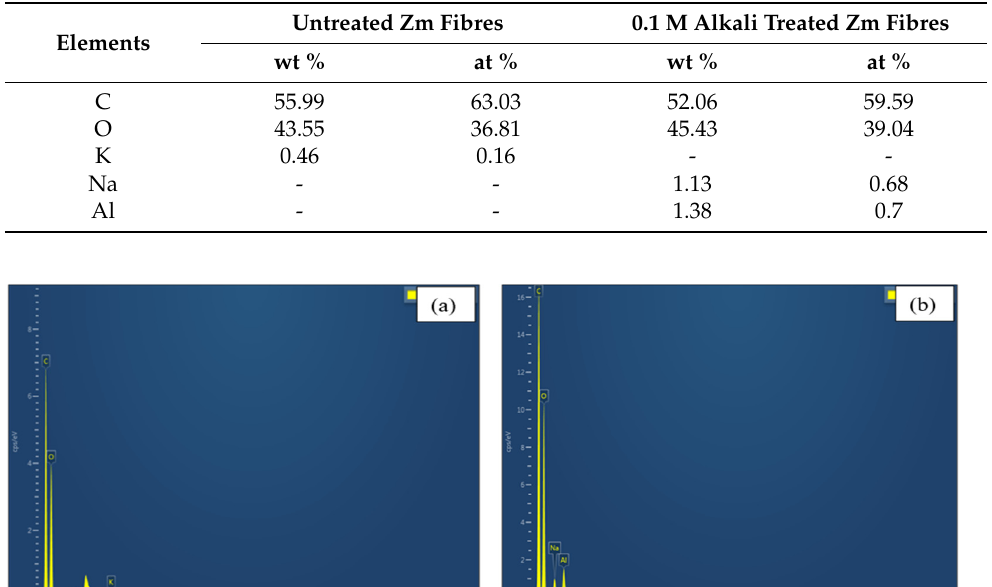
Figure 7. SEM images of 0.1 M alkali treated Zm fibres.